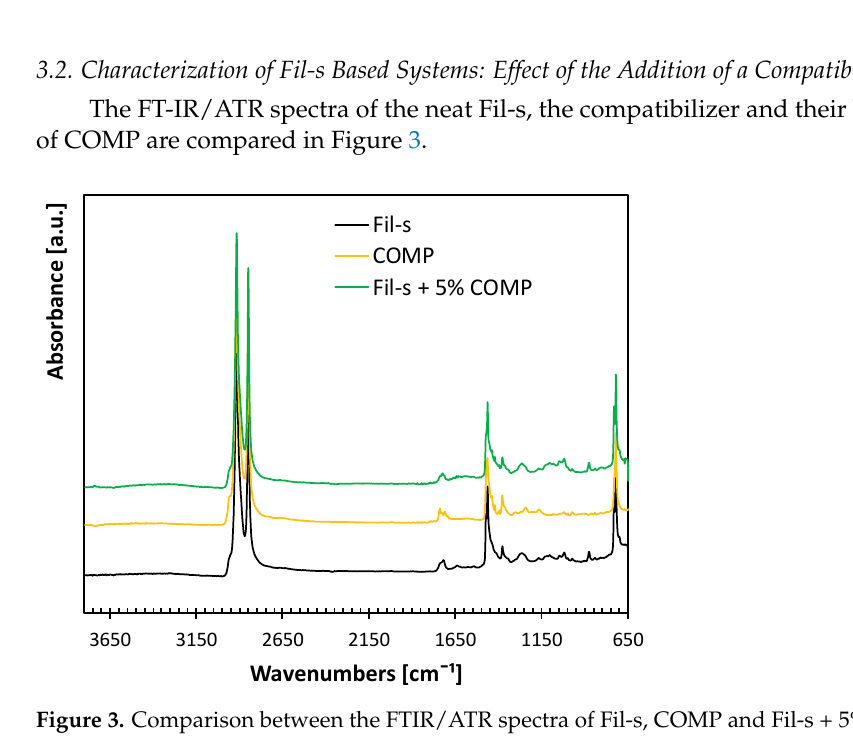
Figure 2. Comparison between the complex viscosity plots of the unwashed, Cold Washed and Hot Washed Fil-s samples.